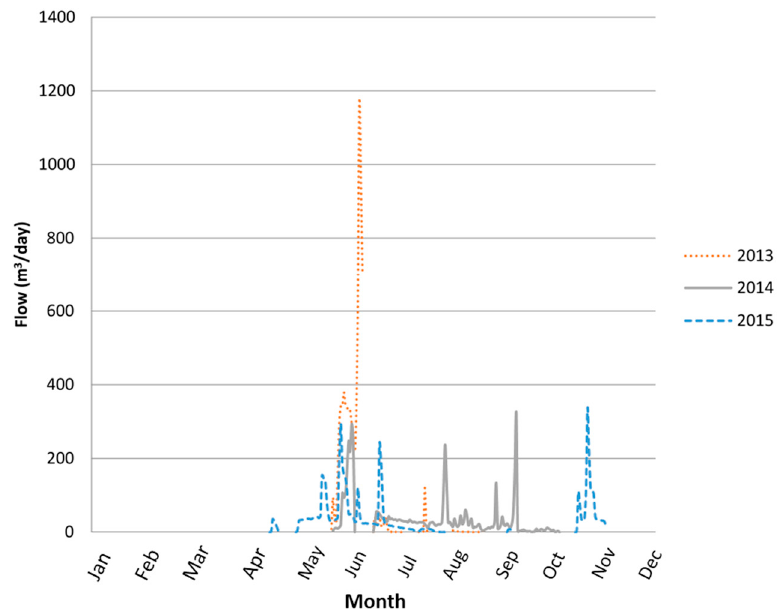
Figure 7. Daily tile flow volumes into the wetland in 2013–2015. Data are missing during the flood periods of 2013 and 2014 due to removal of equipment to avoid damage.